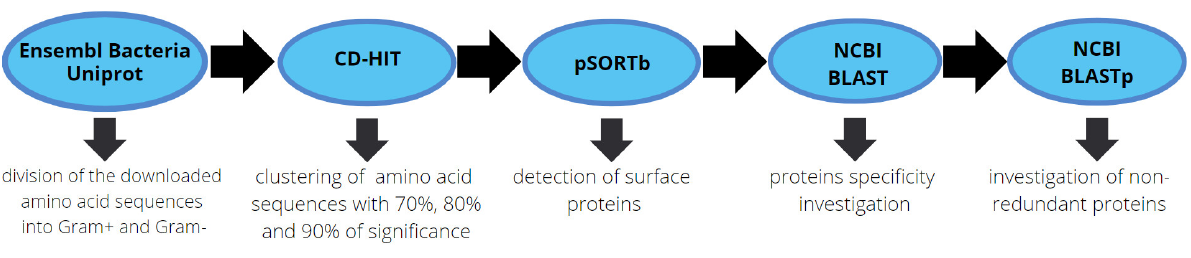
Figure 4. Scheme of the bioinformatic study that led to the identification of FnBPA for S. aureus.